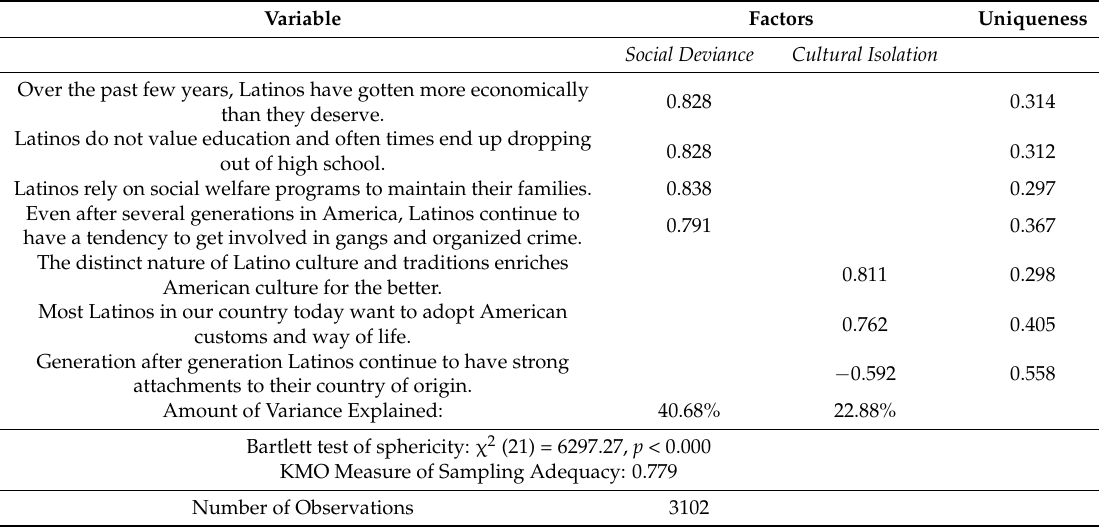
Table 1. Results of the factor analysis on the responses to anti-Latino resentment measures using the principal component factors method with orthogonal varimax rotation. Variable Factors Uniqueness Social Deviance Cultural